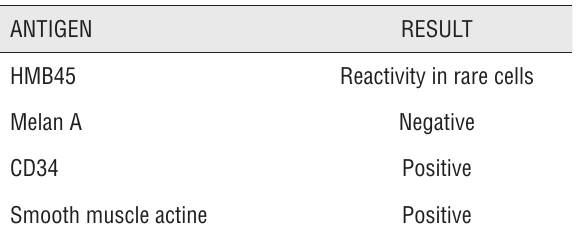
Table 1 - Immuno-histochemical results that confirm